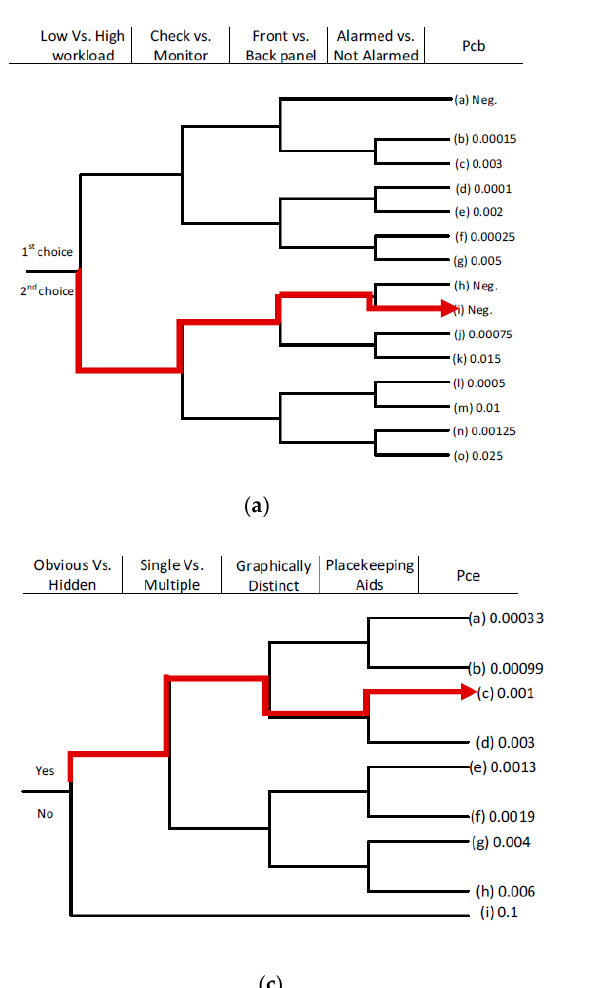
Table 9. Evaluating the diagnosis error for operator failure to start the charging pump for RCP sealing. Error Mechanism